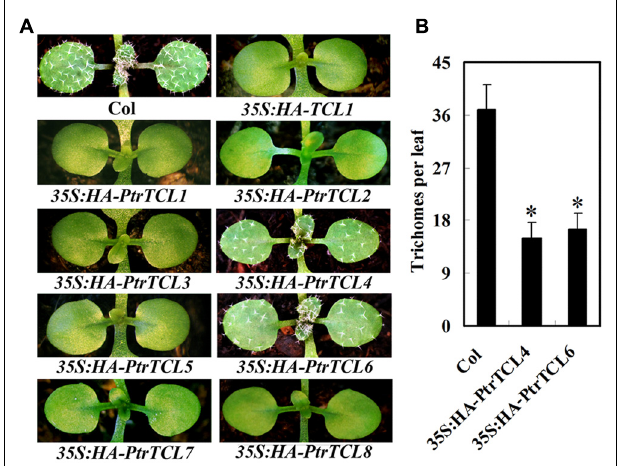
FIGURE 3 | Poplar R3 MYBs negatively regulate trichome formation in Arabidopsis. (A) Trichome phenotypes in Arabidopsis plants expressing poplar R3 MYB genes. All transgenic lines are in Col background. Pictures were taken from 2-week-old, soil-grown seedlings. (B) Trichome density on the first two rosettle leaves of Arabidopsis plants expressing PtrTCL4 and PtrTCL6 . Data represent the mean ± SD of 18 plants. *significantly different from Col wild-type plants ( P < 0.001).